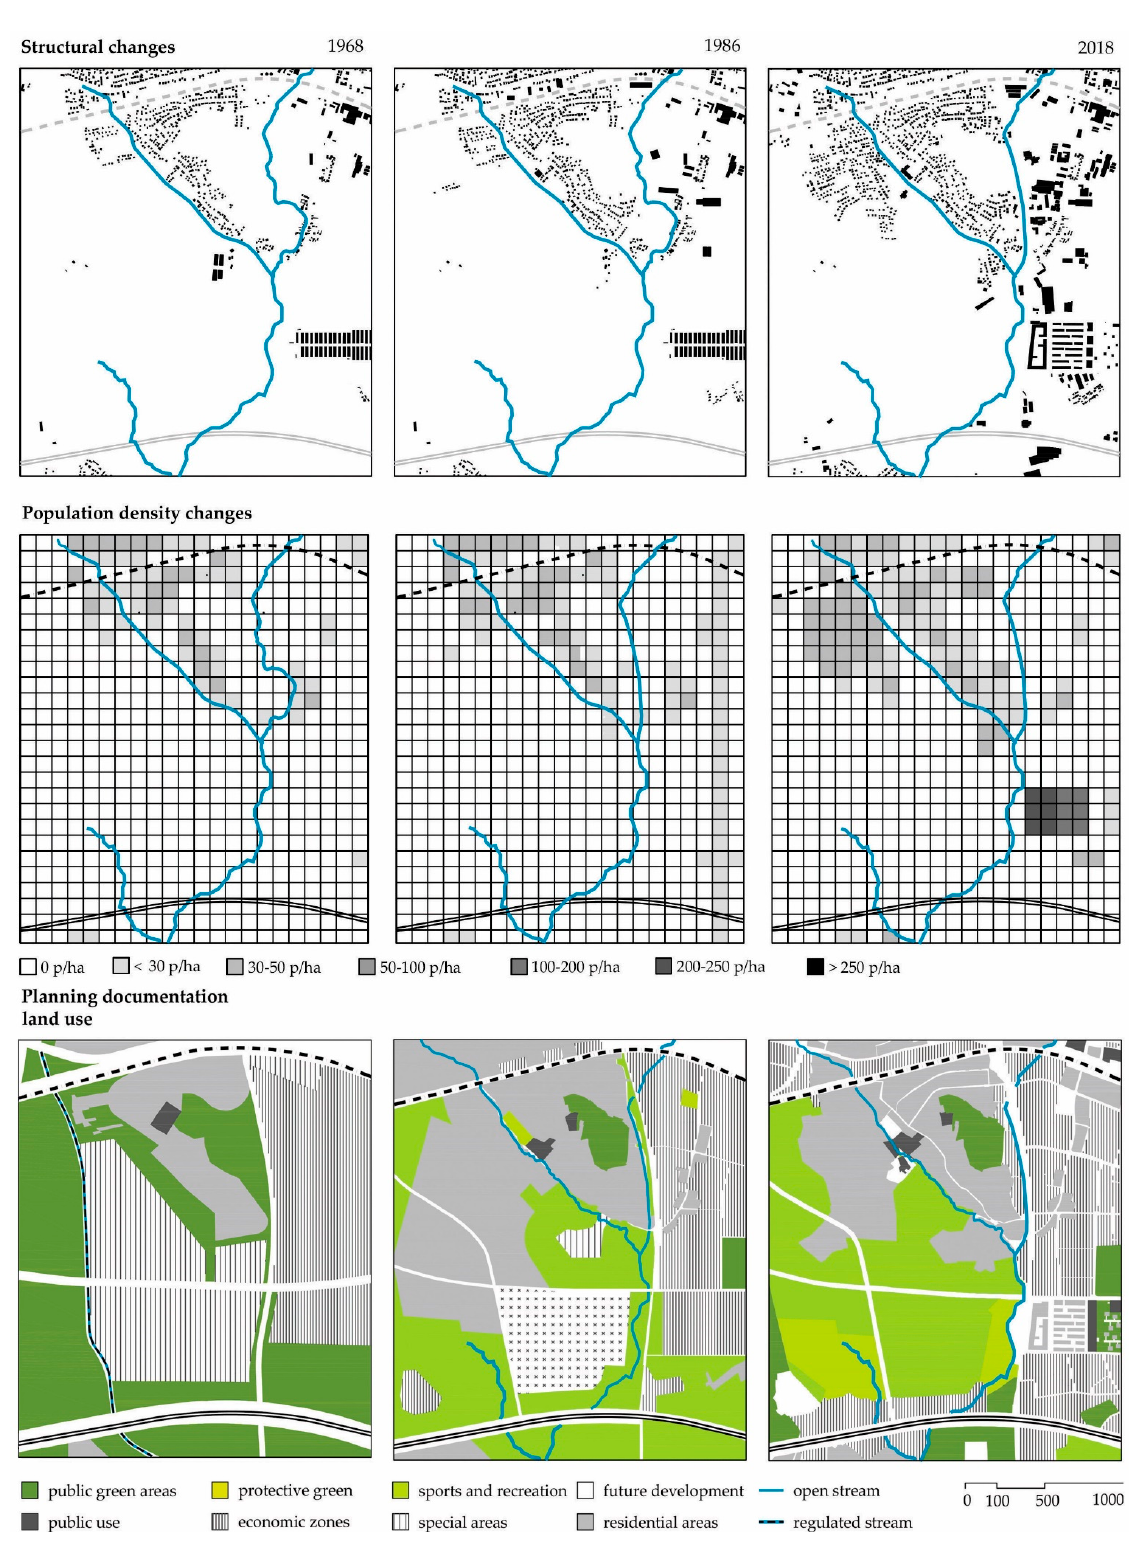
Figure 7. Urban landscape features along the Trnava-Vuger streams. Source: Authors.